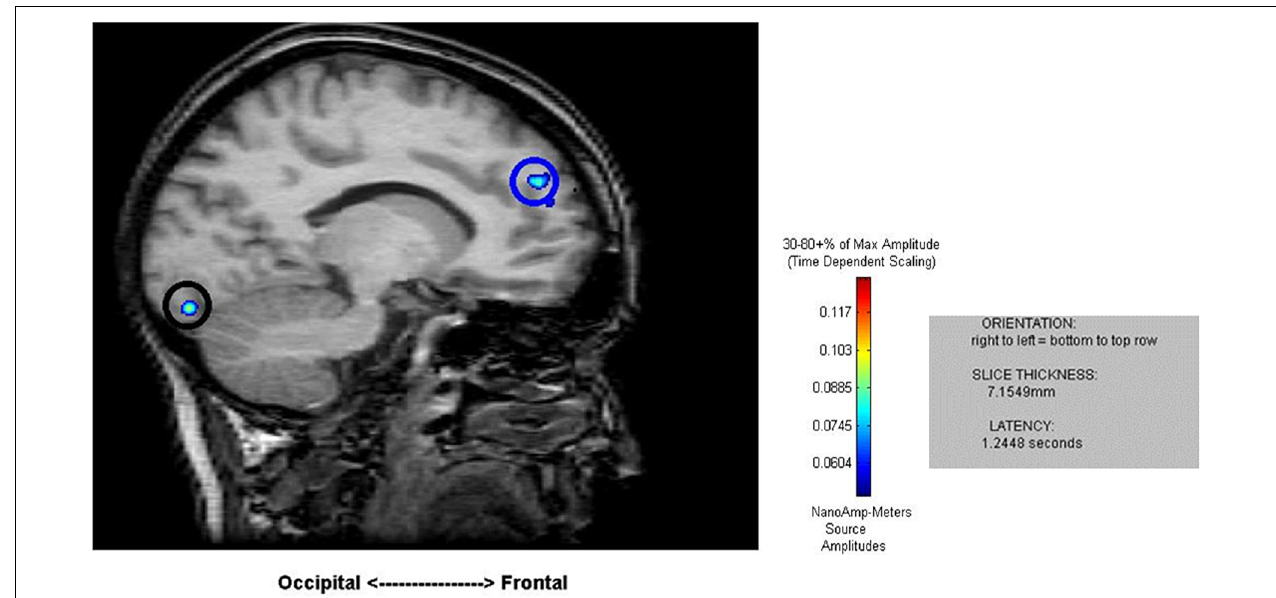
FIGURE 2 | Sample results of the MEG recordings (MR-FOCUSS analyses) for an individual participant showing simultaneous frontal and occipital activation at 1,244 ms latency in five-note transposing (5T).